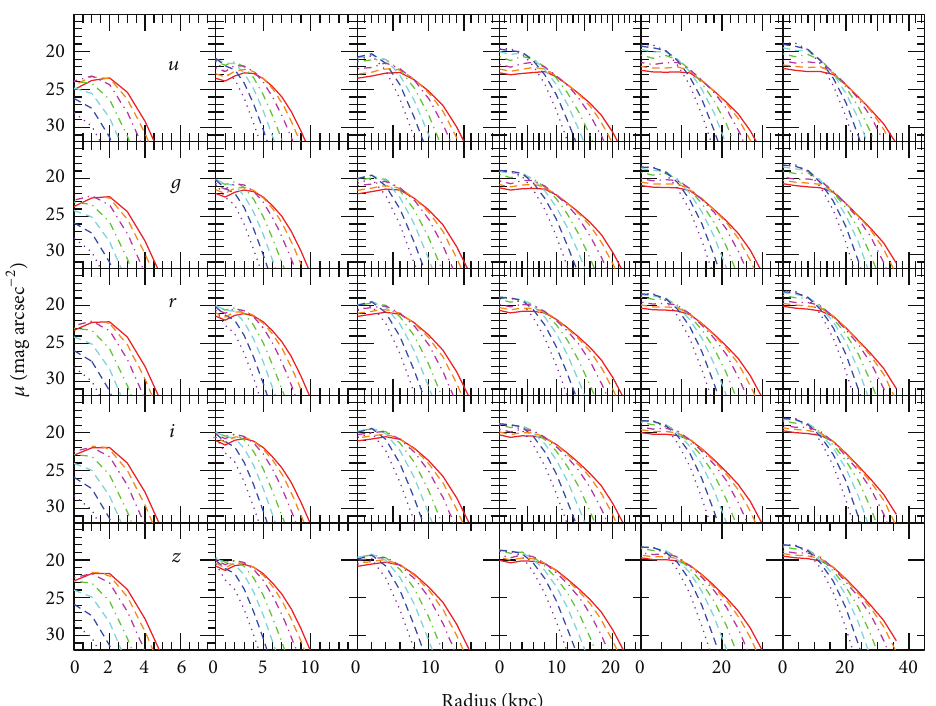
Figure 13: Evolution with redshift of surface brightness profiles for SDSS/SLOAN magnitudes 𝑢 the results for a theoretical galaxy of Table 1, from the galaxy, with 𝑉 max = 78 km s −1 , to the most massive on the bottom for 𝑉 max = 290 km s −1 . Lines purple, blue, cyan, green, magenta, orange, and red are for 𝑧 = 5, 4, 3, 2, 1, 0.4, and 0, respectively.